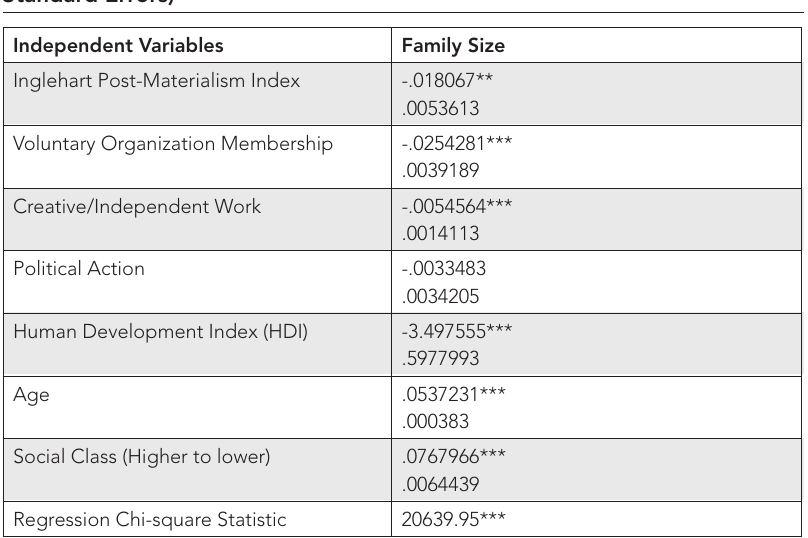
Table 5: Mixed Effects Family Size Regression (Coefficients and Standard